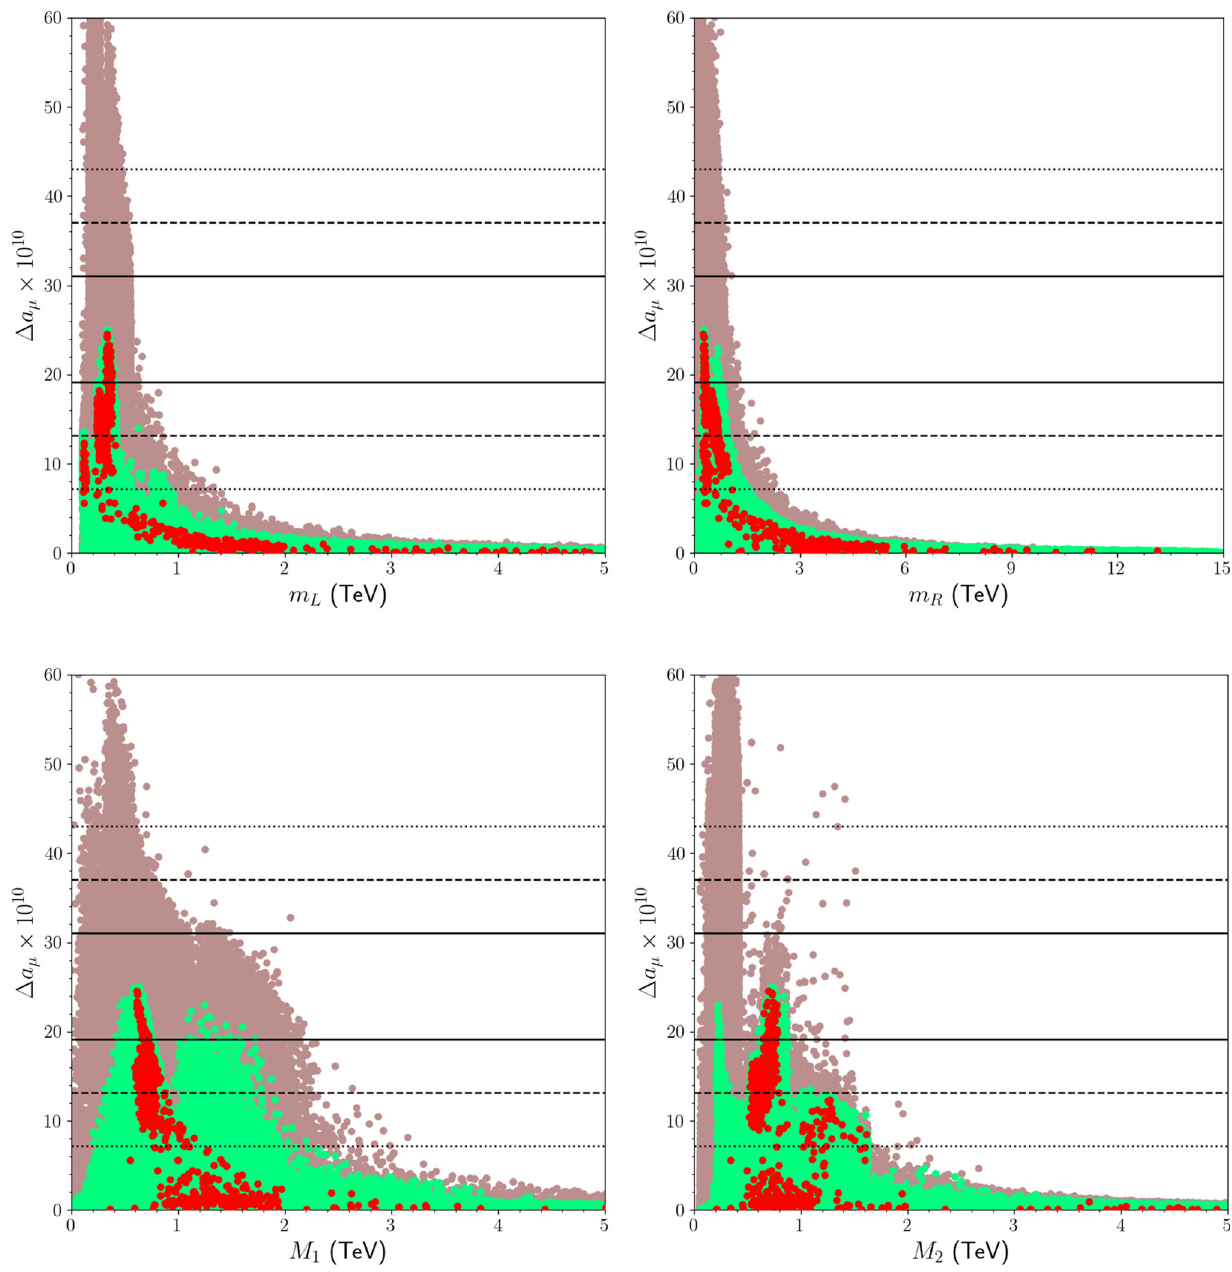
Fig. 2 Plots in the (cid:5) a μ − m L , (cid:5) a μ − m R , (cid:5) a μ − M 1 and (cid:5) a μ − M 2 planes. All solutions are compatible with the REWSB and LSP neu- tralino conditions. The green points are allowed by the mass bounds and constraints from rare B -meson decays. The red points form a subset